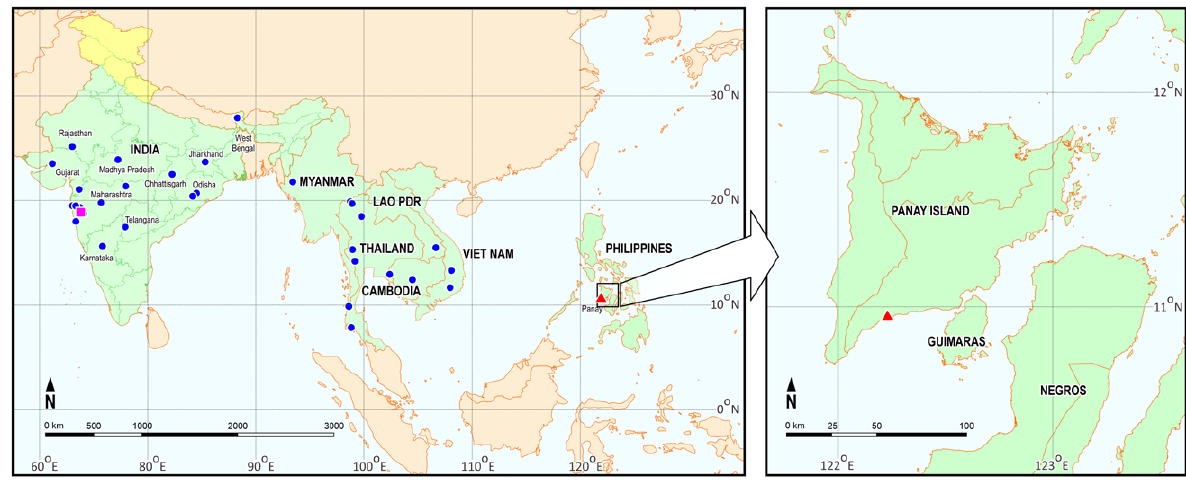
Figure 2. Distribution of Habenaria gibsonii var foetida (Blatt. & McCann.) Purple square = type locality; Blue circles = previous records; Red triangles = new records in the Philippines. The yellow-shaded area represents a reported range of H. gibsonii var. foetida in West Himalaya but was not verified by the